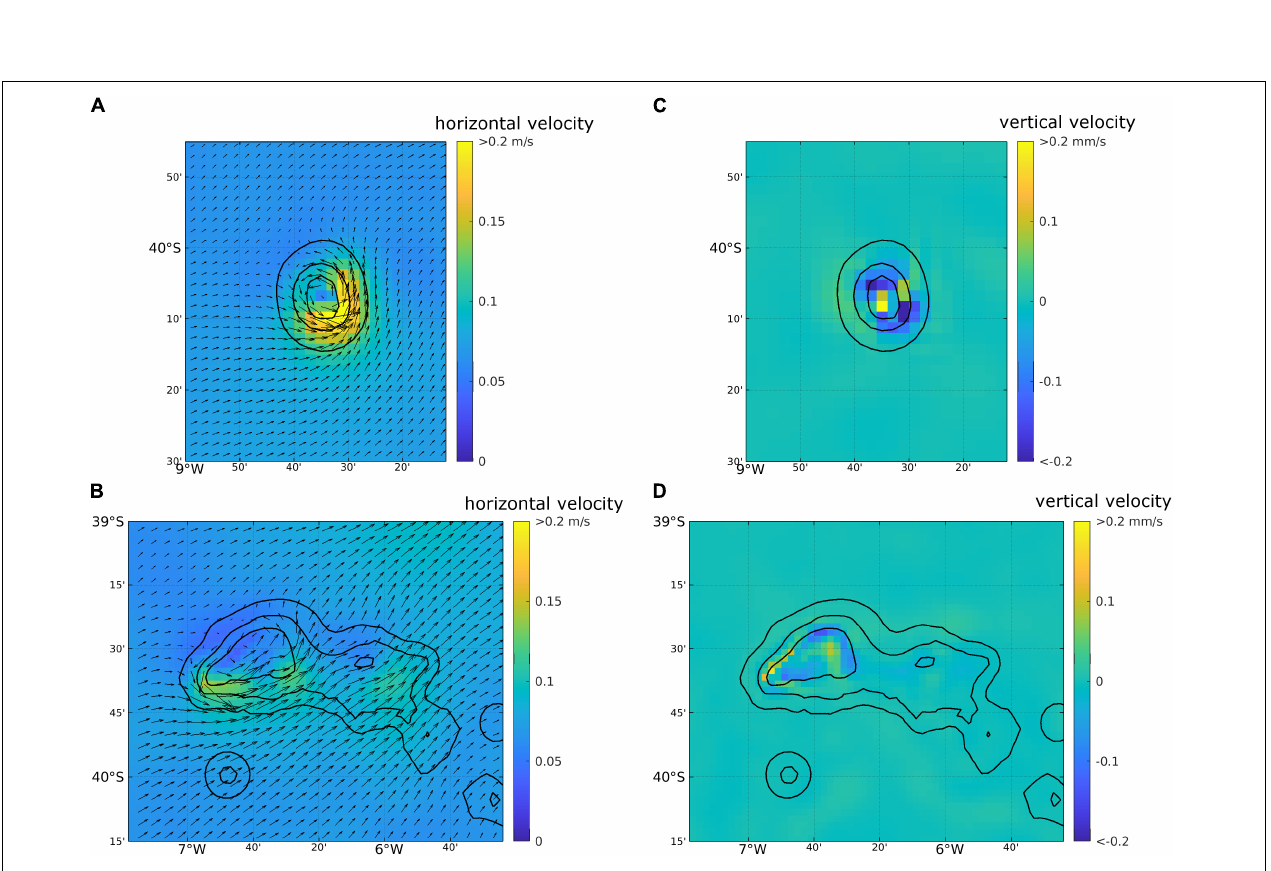
FIGURE 8 | Presumed bluenose warehou ( Hyperoglyphe antarctica ) aggregation at McNish seamount visualised in two ways: (A) Interpolated map of NASC of the bluenose aggregation at McNish. (B) 70 kHz Sv (volume backscattering strength) echogram curtain of the bluenose aggregation overlaid on the 3D McNish elevation.